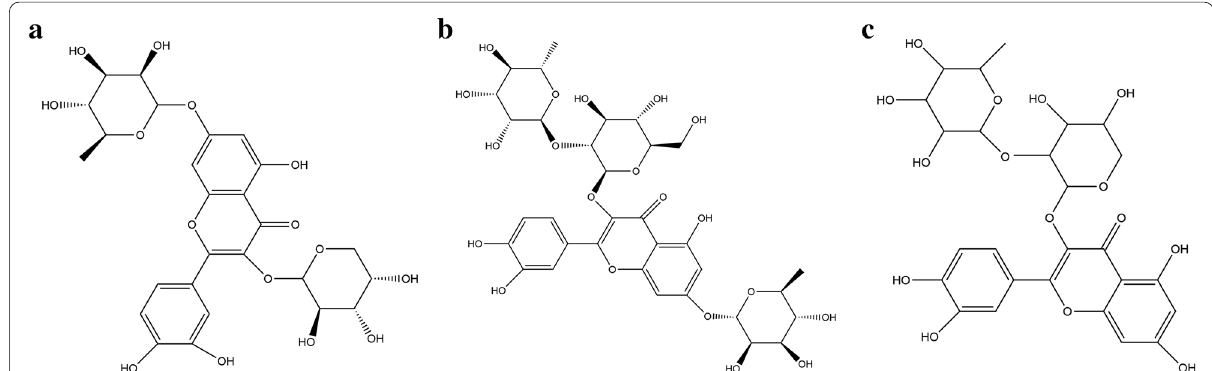
Fig. 10 a Chemical structure of quercetin 3-O-arabinoside 7-O-rhamnoside. b Chemical structure of quercetin-3-neohesperidoside-7-rhamnoside. c Chemical structure of quercetin 3-[rhamnosyl-(1- >